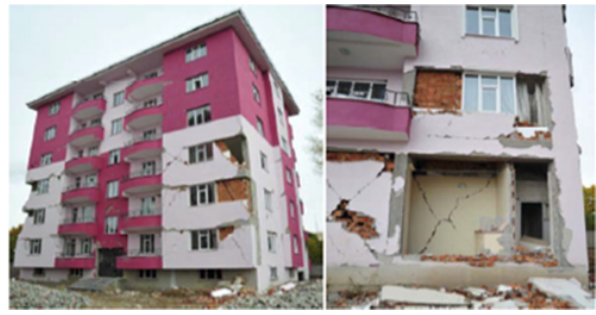
Figure 22. Damage observed in non-bearing brick-infilled